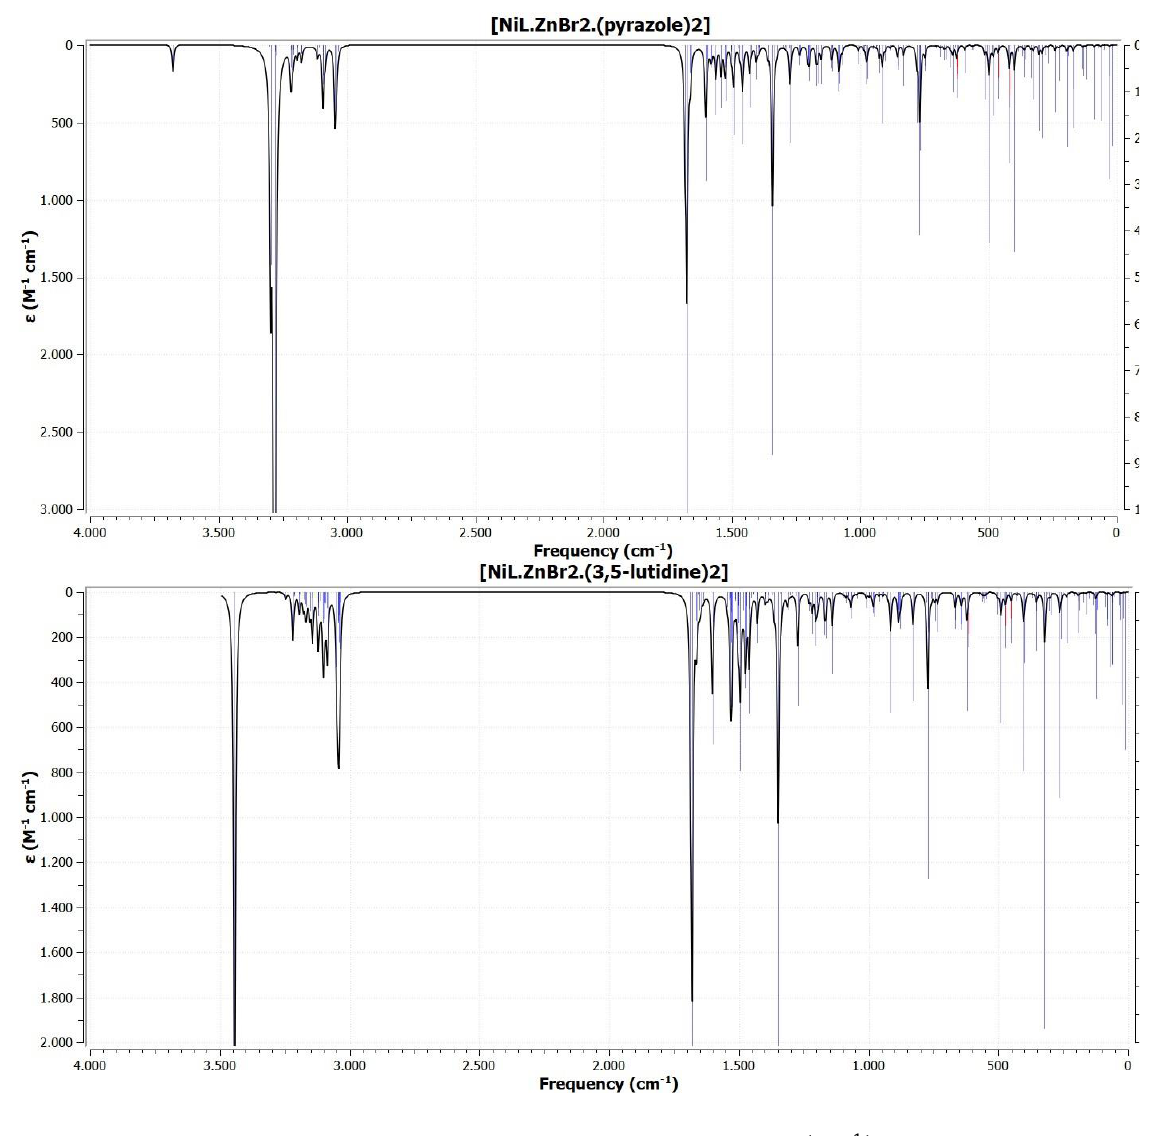
Figure S1. Calculated vibrational wave number (cm -1 ) assignments of [NiL·ZnBr ·(pyrazole) ] and [NiL·ZnBr ·(3,5-lutidine) ] using DFT based on 2 2 2 2 B3LYP/genecp method and 6-31G(d)/LanL2dz basis sets (without